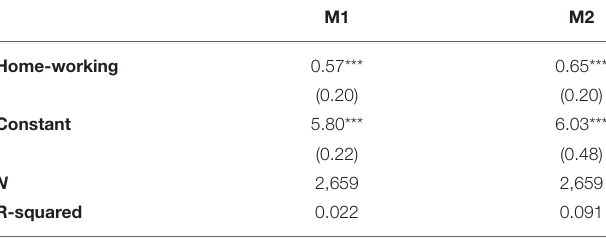
TABLE 3 | Linear regression models.